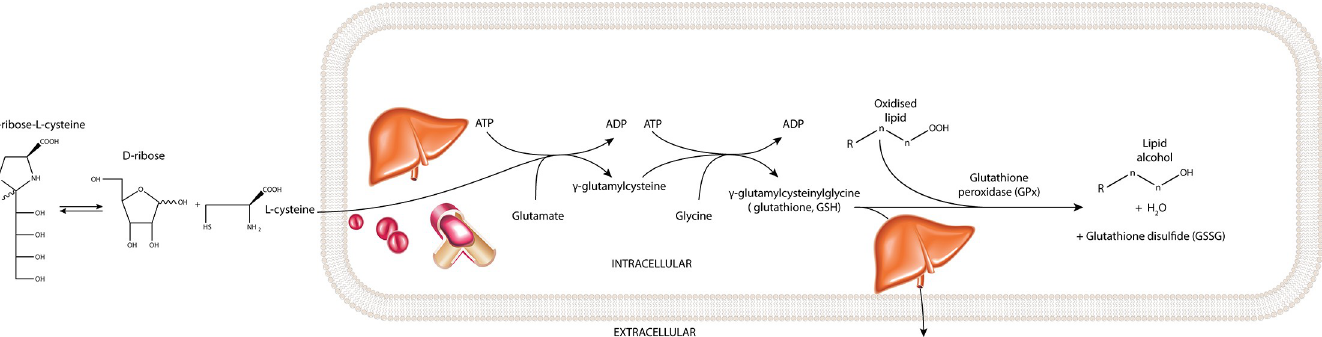
Fig 1. Proposed mode of action of ribose-cysteine. Ribose-cysteine releases L-cysteine via hydrolysis in the plasma compartment which is taken up by the liver and utilised to promote GSH synthesis. The increase in GSH promotes an increase in GPx activity to give a reduction in oxidised lipid content. Excess GSH is exported by the